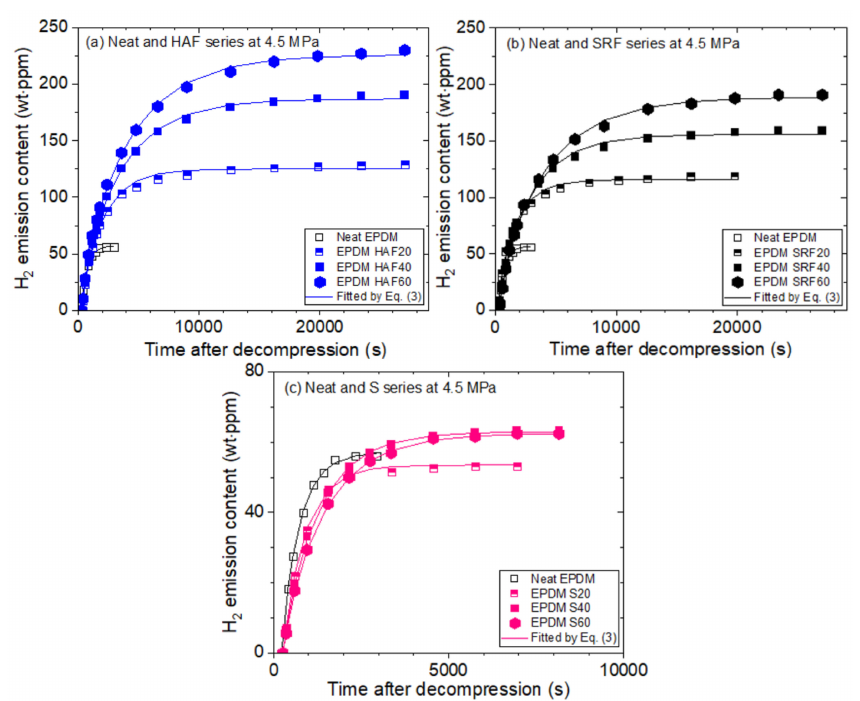
Figure 3. Time-varying H 2 emission content of the ( a ) EPDM HAF series, ( b ) EPDM SRF series and ( c ) EPDM S series after exposure to 4.5 MPa H 2 for 24 h and decompression. The solid lines represent the fitted results by Equation (3).